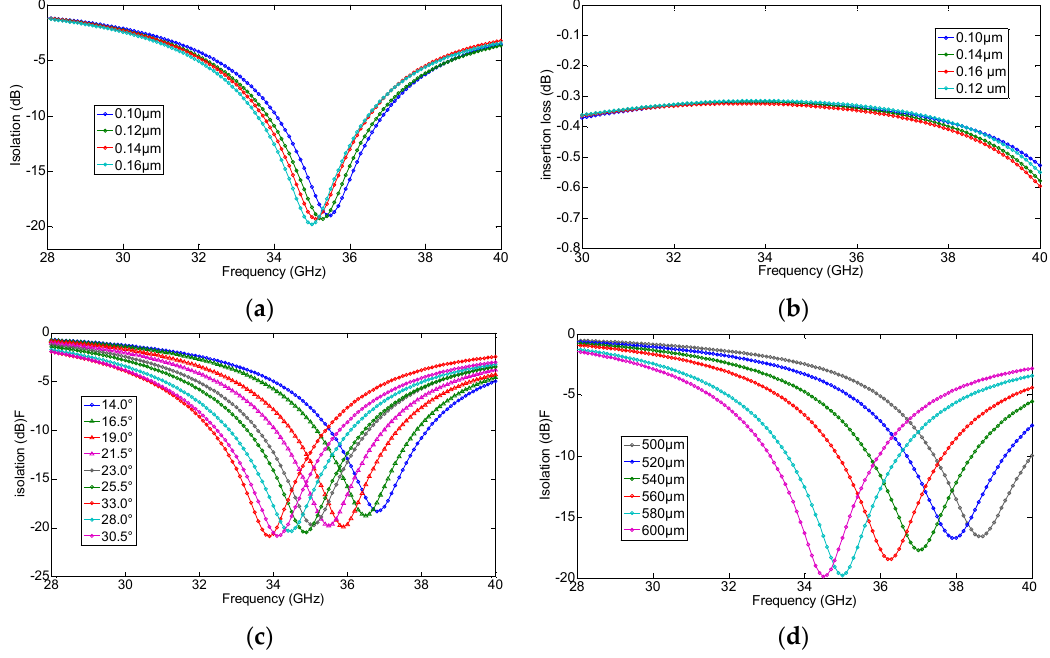
Figure 3. The relationship between resonant frequency (when the switch in the down state) and structure parameters. ( a ) The variation of the thickness of dielectric (isolation); ( b ) The variation of the thickness of dielectric (insertion loss); ( c ) The variation of the angle of the sector open stub; ( d ) The variation of the radius of the sector open stub.